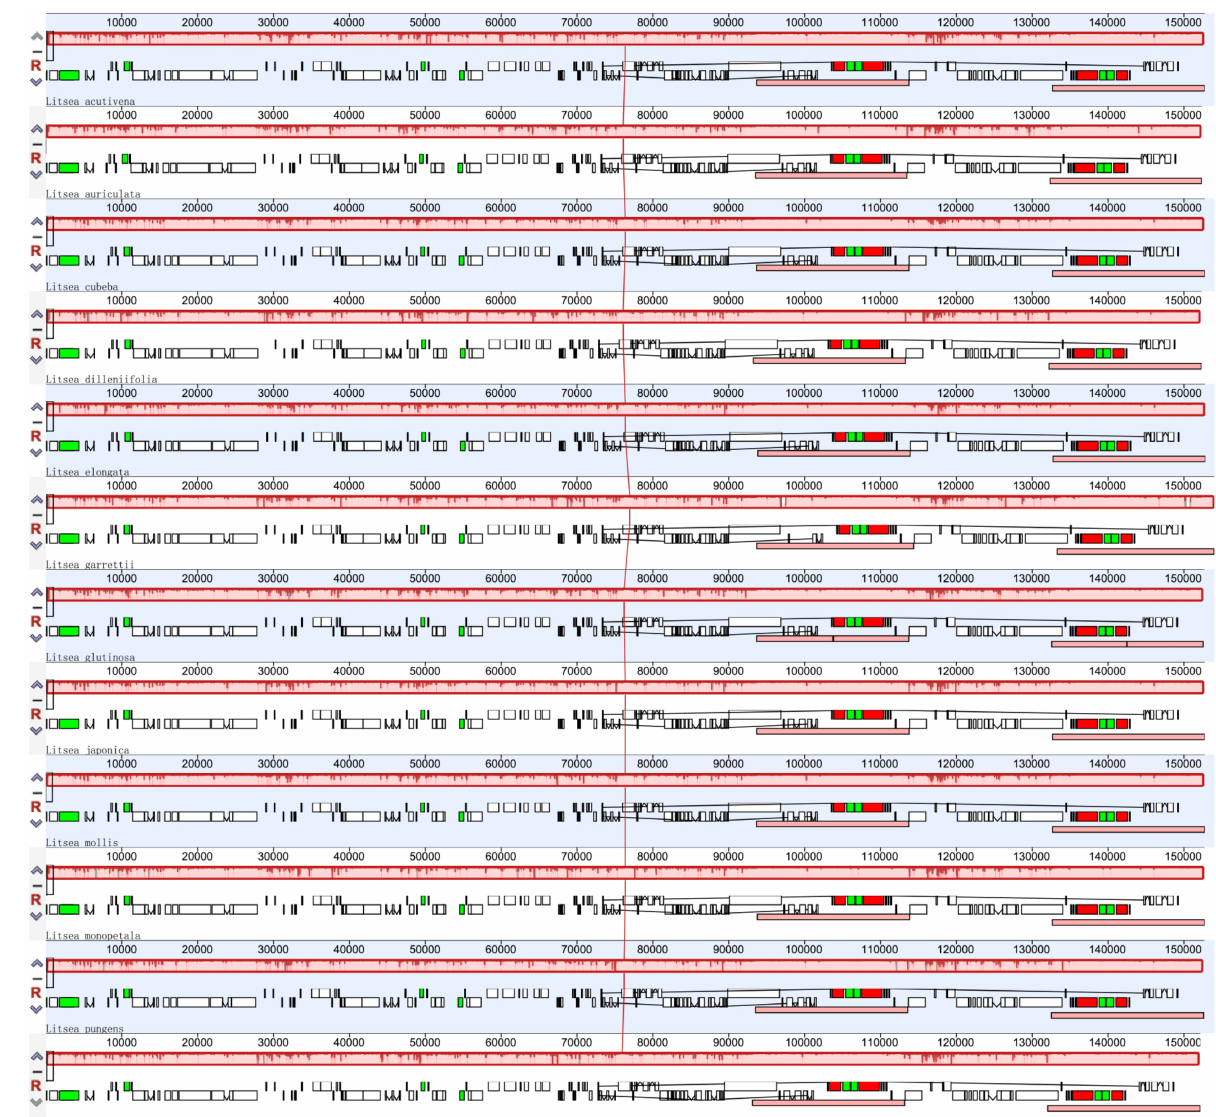
Figure 2. Alignment of 12 Litsea chloroplast genomes. The L. acutivena genome is shown at the top as the reference genome. Within each of the alignment, local collinear blocks are represented by blocks of the same color connected by